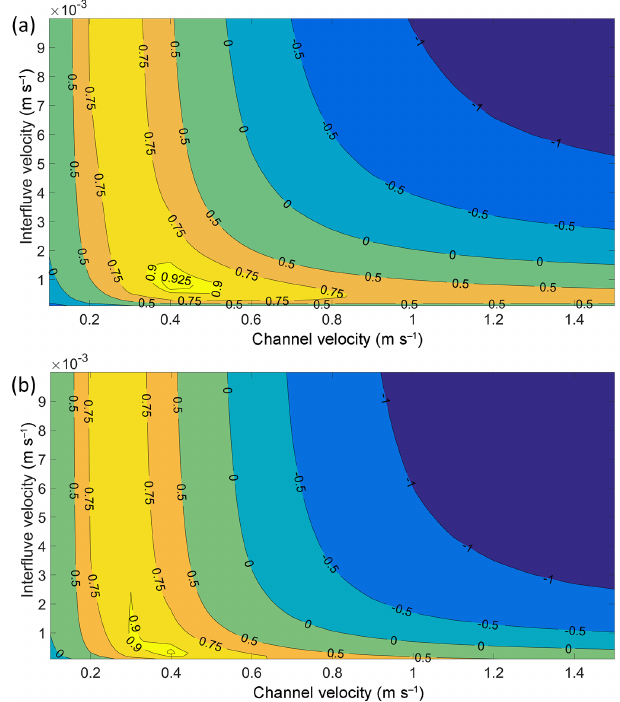
Figure 5. Calibration of channel and interfluve velocities using (a) conservative and (b) nonconservative supraglacial river de- lineations. Contour labels show Nash–Sutcliffe model efficiencies (NSEs) obtained by applying different combinations of mean inter- fluve ( v h ) and open-channel velocities ( v c ) and comparing with the field-measured hydrograph just upstream of the Rio Behar catch- ment terminal outlet